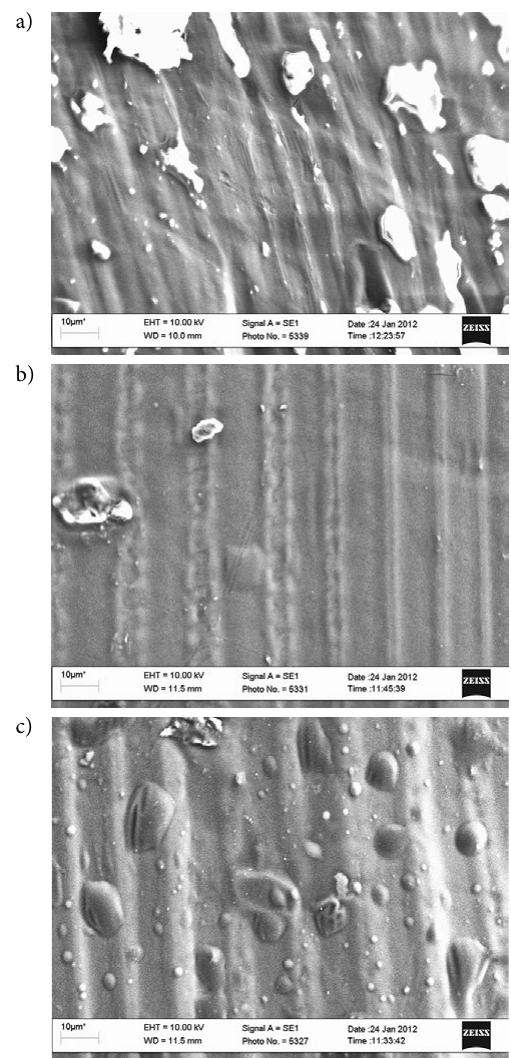
Fig. 9. View of chopped straw coated with a different content of infrared absorbers: a) 3%, b) 5%,